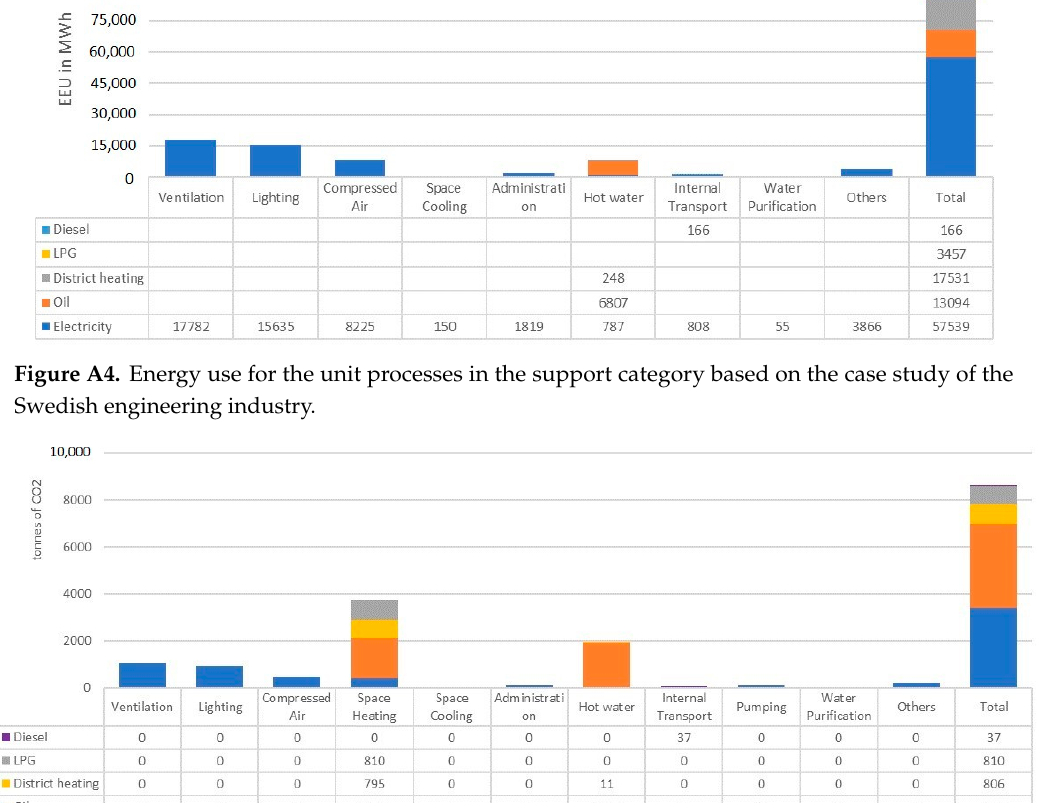
Figure A3. CO 2 emissions for the unit processes in the production category based on the case study of the Swedish engineering industry (Scenario 2).